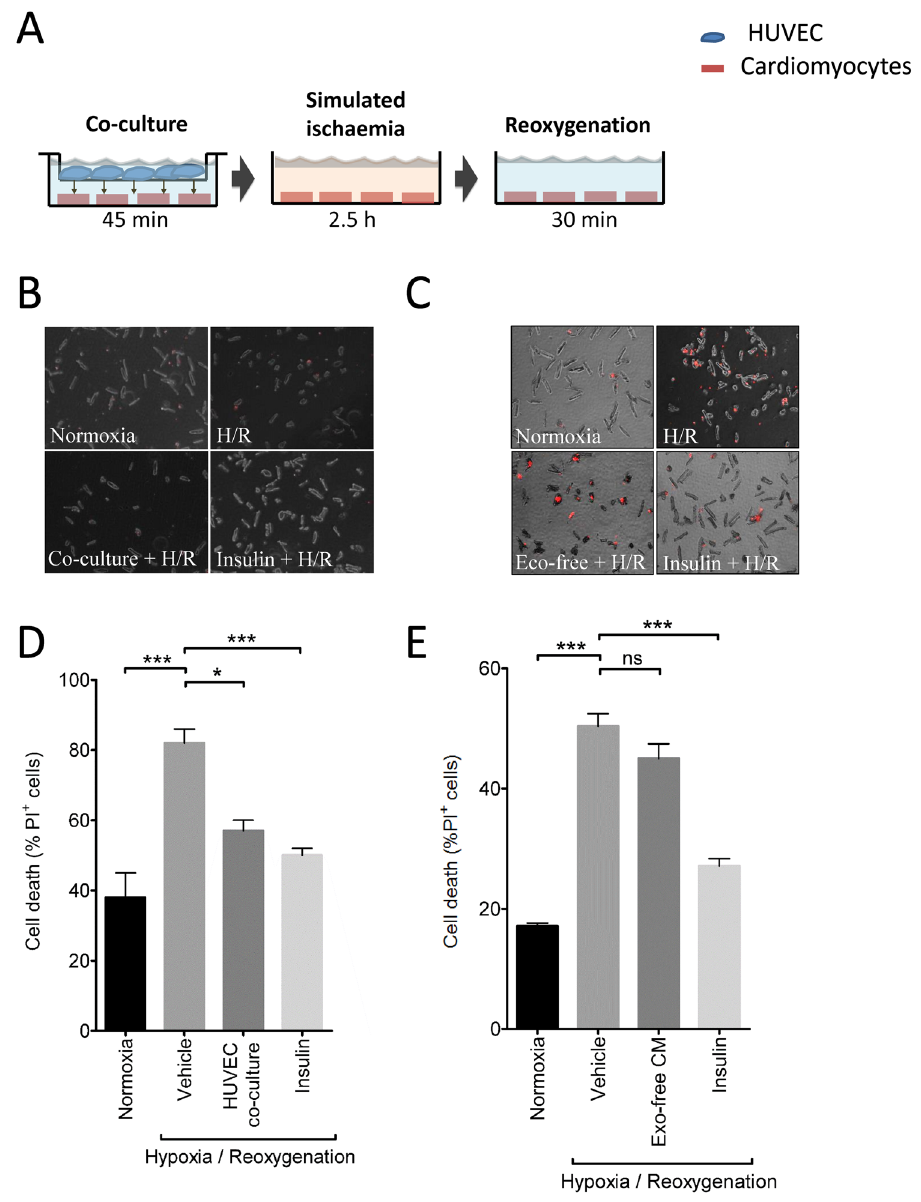
Figure 1. HUVEC release cardioprotective factors. ( A ) Experimental protocol for the co-culture of HUVEC with adult rat cardiomyocytes using a trans-well system, followed by hypoxia and reoxygenation (H/R). Separate wells of cardiomyocytes were maintained in normoxic medium. Insulin pre-treatment was used as a positive control for cardioprotection. ( B , C ) Representative images of cardiomyocytes stained with propidium iodide (PI) at the end of the H/R protocol. Fluorescent images (PI staining in red) were overlaid with phase contrast images of cells. ( D , E ) Percentage of dead cells after normoxic culture, after H/R, after HUVEC co-culture (D, N = 5), or after addition of exosome-free conditioned medium (“exo-free CM”) (E, N = 3). * P < 0.05, *** P <